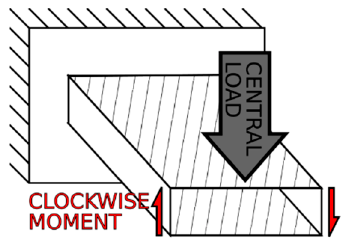
Figure 21. Bend-twist coupling.